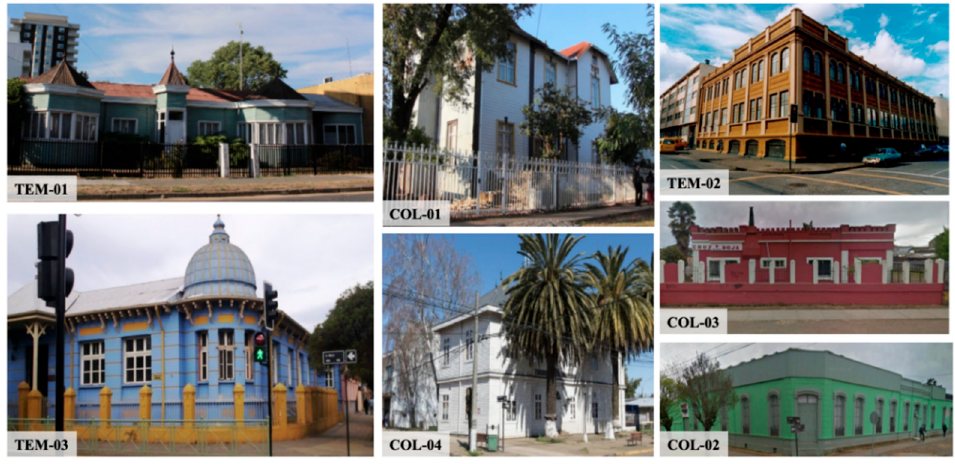
Figure 2. Samples under